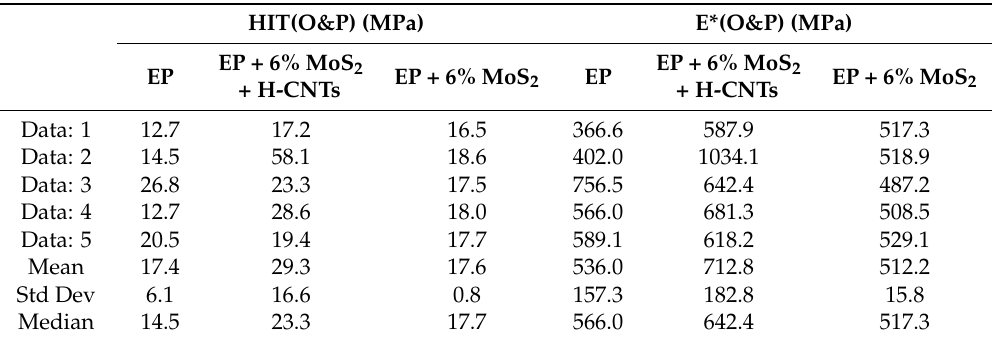
Table 3. Nanoindentation